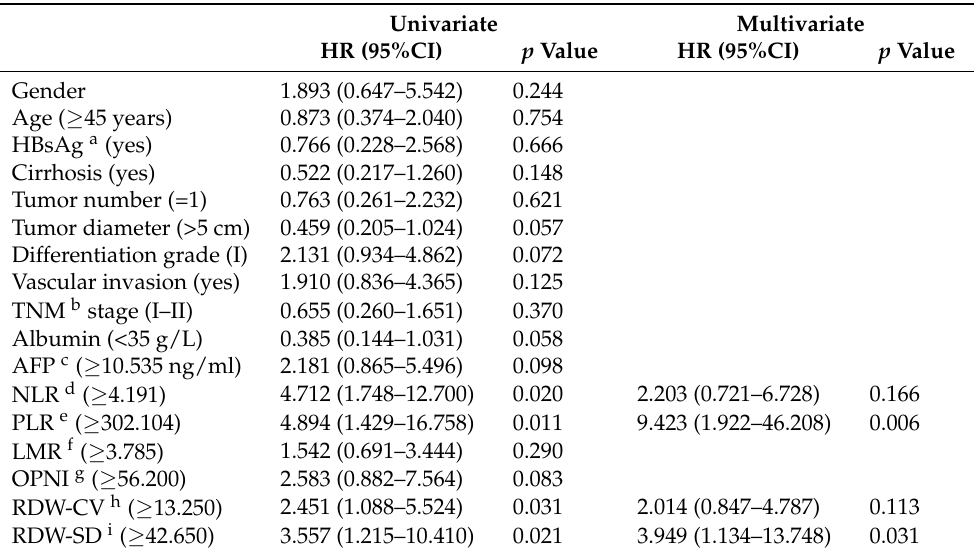
Table 3. Univariate and multivariate analyses of the prognostic factors of overall survival of HCC patients who received curative resection.